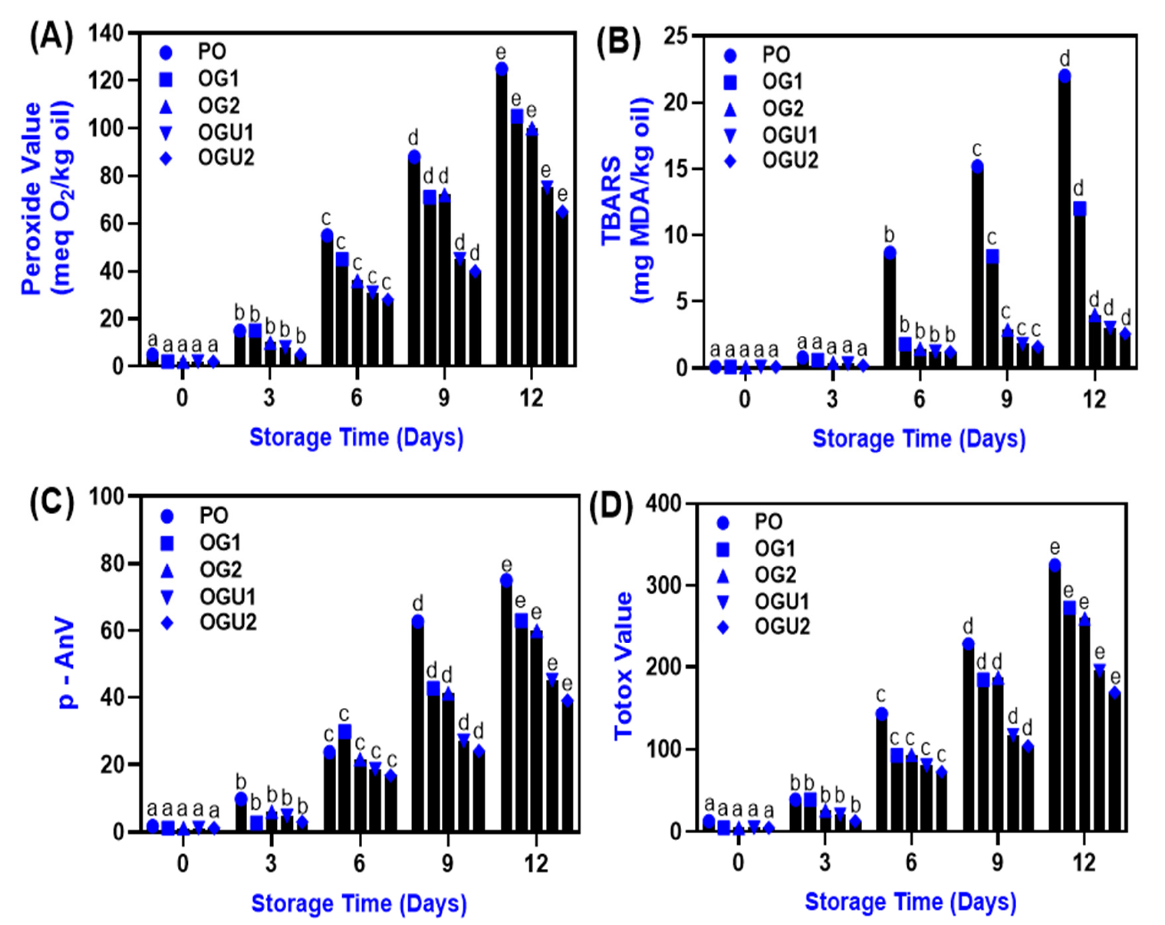
Figure 7. Changes in lipid oxidation (peroxide value ( A ), TBARS ( B ), p-AnV ( C ) and totox value ( D )) during storage at ambient temperature in the different frying mediums that fried SDEW instant noodles. Note: PO represents palm oil; OG1 represents palm oil–carnauba wax (5 g/100 g); OG2 rep- resents palm oil–carnauba wax (10 g/100 g); OGU1 represents palm oil–carnauba wax (5 g/100 g) ho- mogenized with ultrasonication; and OGU2 represents palm oil–carnauba wax (10 g/100 g) homoge- nized with ultrasonication. The different alphabets (a–e) in the figures indicate significant